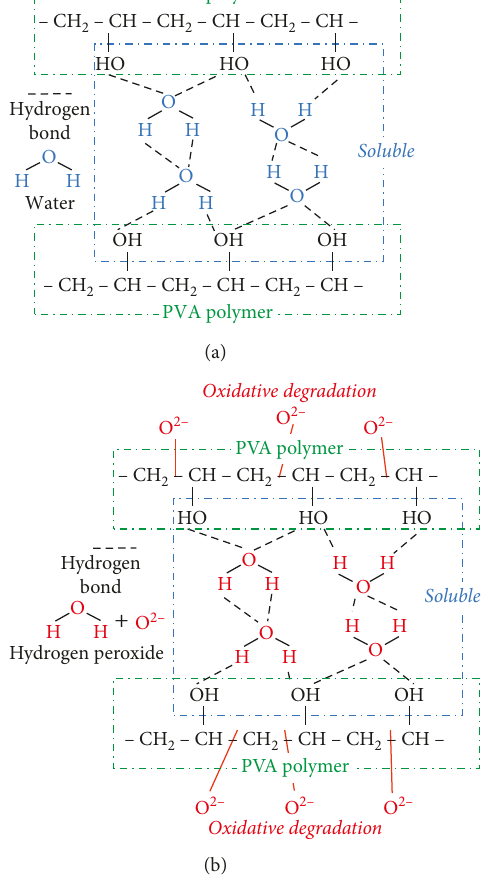
Figure 6: Schematic illustration of the mechanism of the disso- lution and degradation of PVA materials by (a) water and (b) hydrogen